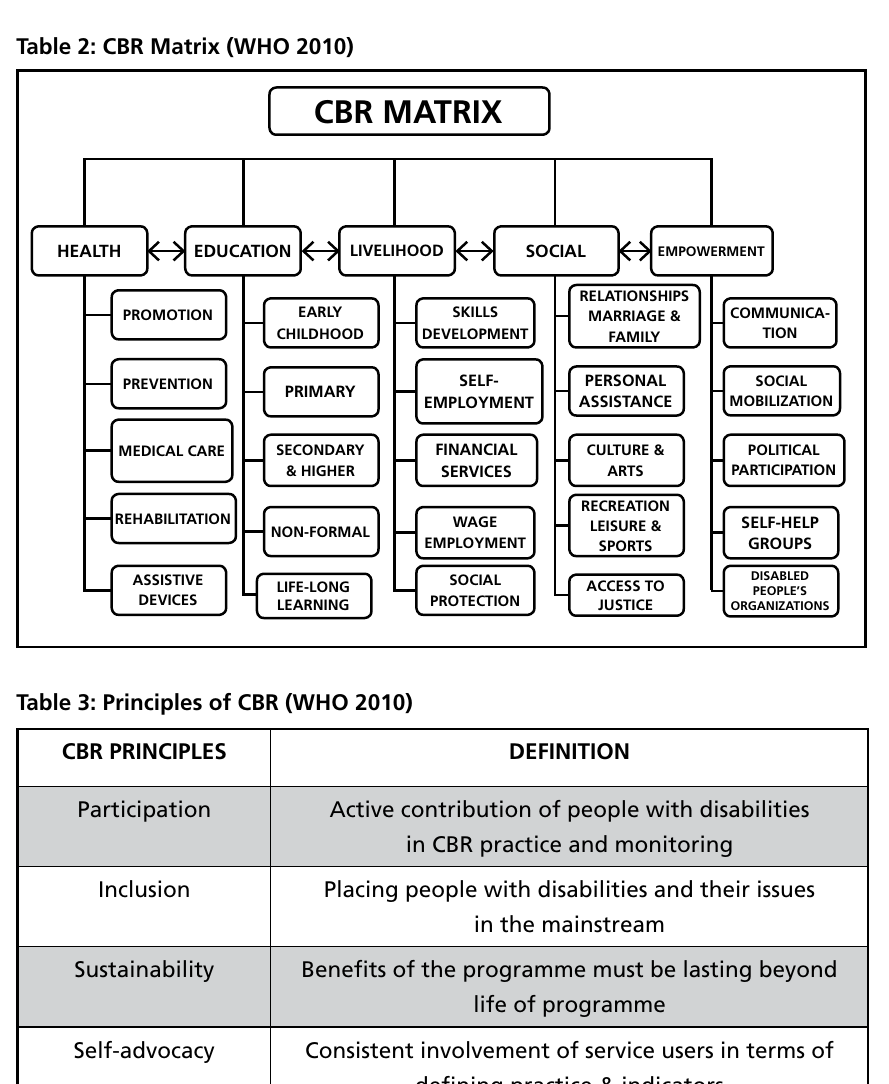
table 2: cbR Matrix (WhO 2010)